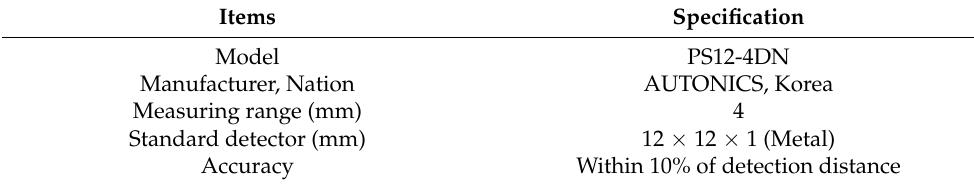
Table 5. Specifications of the digital level.